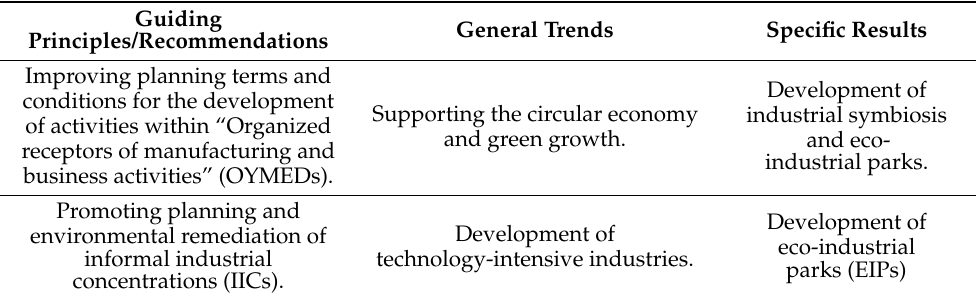
Table 8. Guiding principles to adapt BPs to current trends and enhance their